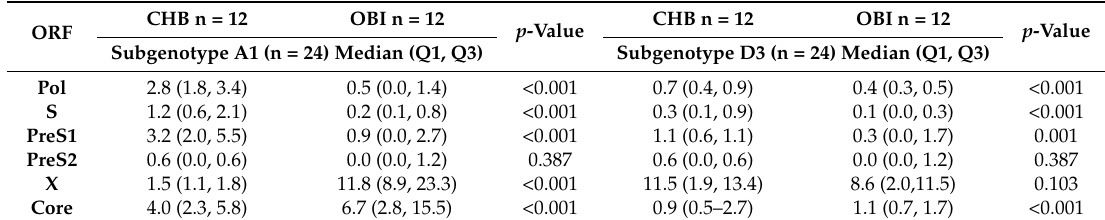
Table 2. Comparison of the median nnucleotide pairwise distance (%) between chronic and occult infections by open reading frame and subgenotype.